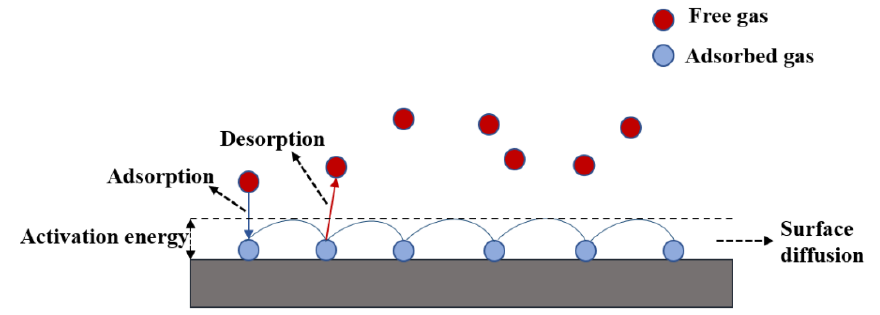
Figure 4. Adsorption and desorption of gas molecules (modified from [48]).